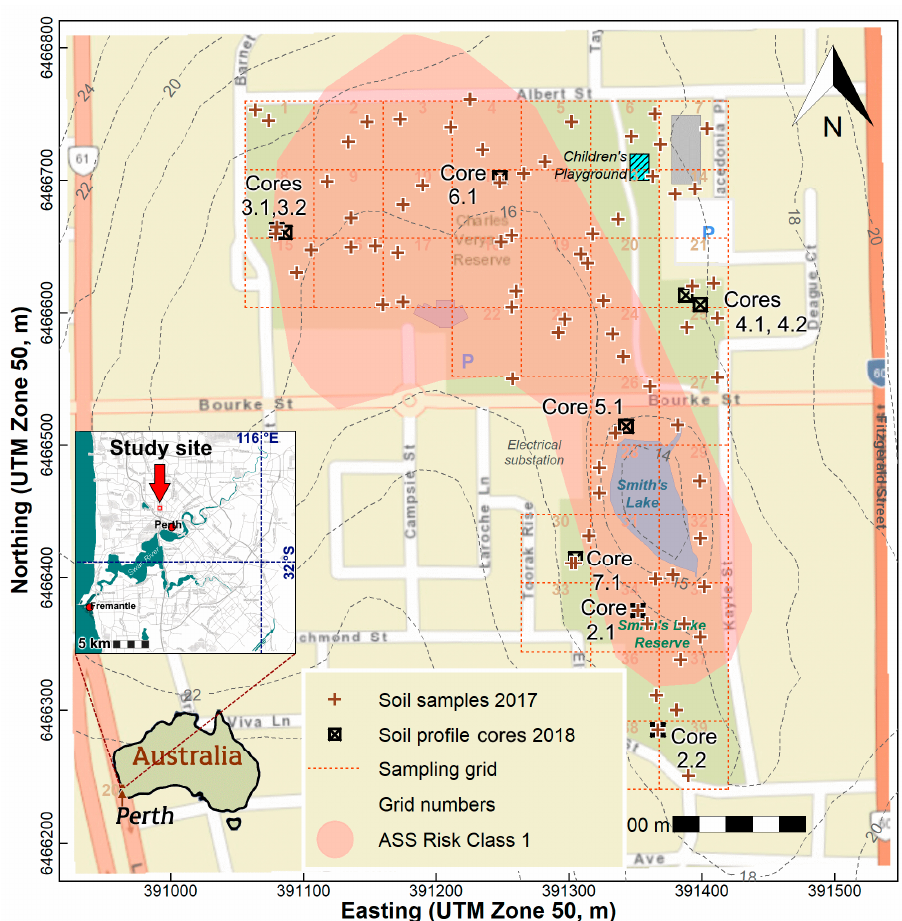
Figure 1. Street map showing soil sampling locations, and the initial grid used for sampling design, at Smith’s Lake and Charles Veryard Reserves. Contours are land elevations in metres; the pale red polygon shows moderate to high acid sulfate soil (ASS) risk.